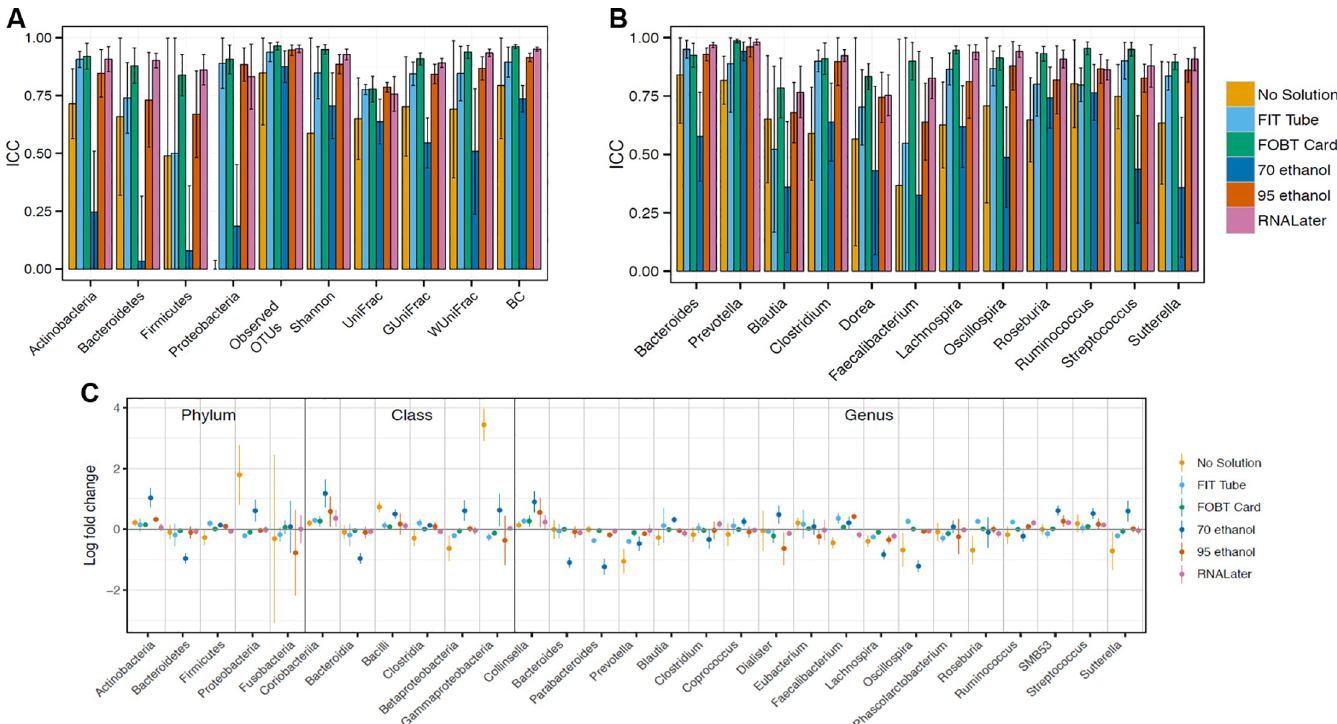
Fig 3. Meta-analyzed ICCs and log-fold changes based on random effects models for microbiome stability comparing fecal samples frozen on day-4/7 to those frozen at day-0 for six fecal sample collection methods among 132 participants in five studies (Mayo 1-Knight lab, Mayo 1-Mayo lab, Mayo 2, Bangladesh, and Colorado). ICCs are based on ten microbial composition metrics (panel A; square root transformed abundance of four phyla, two alpha diversity metrics [number of observed OTUs and Shannon index] and four beta diversity metrics [unweighted UniFrac, generalized UniFrac, weighted UniFrac, and Bray-Curtis distance]), and select square root transformed bacterial genera (panel B) with prevalence in the population > 80% and a mean relative abundance > 0.2%. Log-fold changes in relative abundance from day-0 (panel C) are based on select taxa with prevalence > 50% and a mean read count > 10. All error bars represent 95% CIs. Abbreviations : BC , Bray- Curtis distance; FIT , fecal immunochemical tests tubes; FOBT , fecal occult blood test cards; FTA , Flinders Technology Associates cards; GUniFrac , generalized UniFrac distance; ICC , intraclass correlation coefficient; UniFrac , unweighted UniFrac distance; WUnifrac , weighted UniFrac distance .